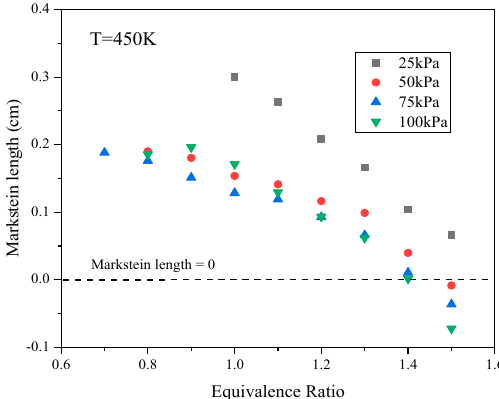
Figure 8. Markstein lengths at different pressures as functions of the equivalence ratio.